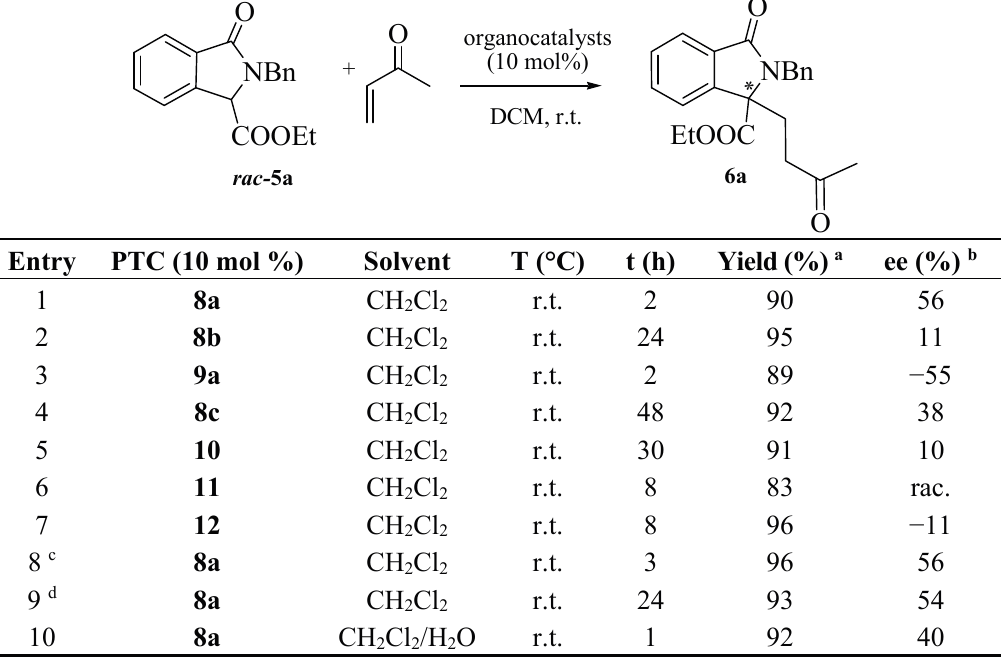
Figure 3. A survey of chiral phase transfer catalysts and organocatalysts. Table 2. Phase transfer catalyzed asymmetric Michael